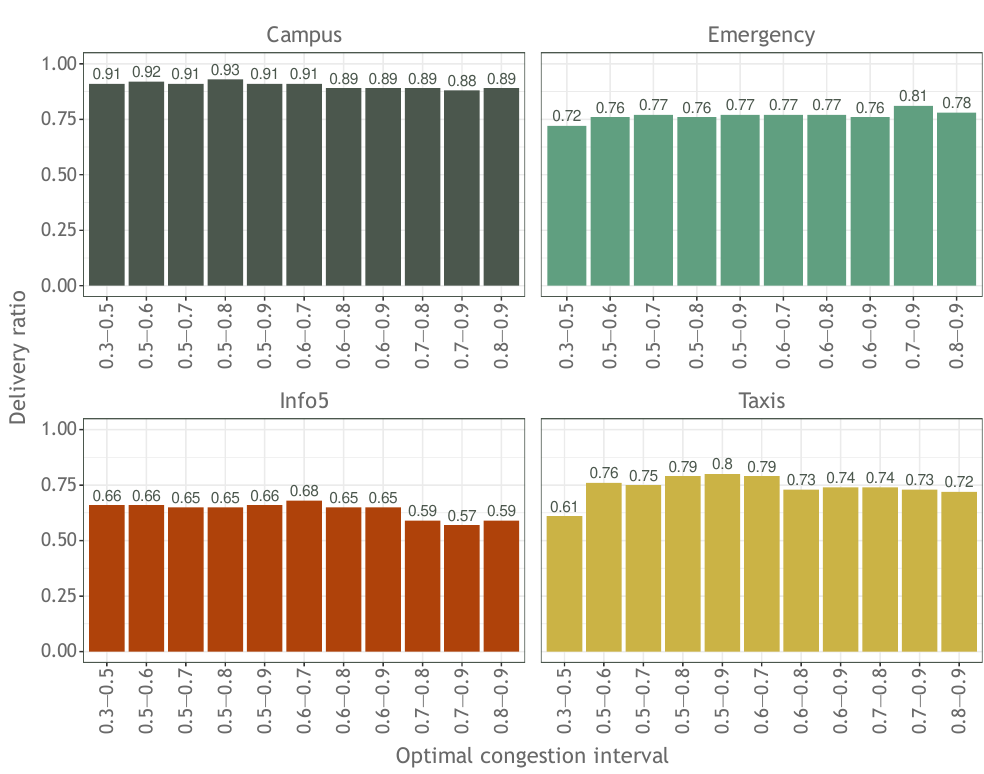
Figure 13. Delivery ratio depending on the optimal congestion interval per scenario.